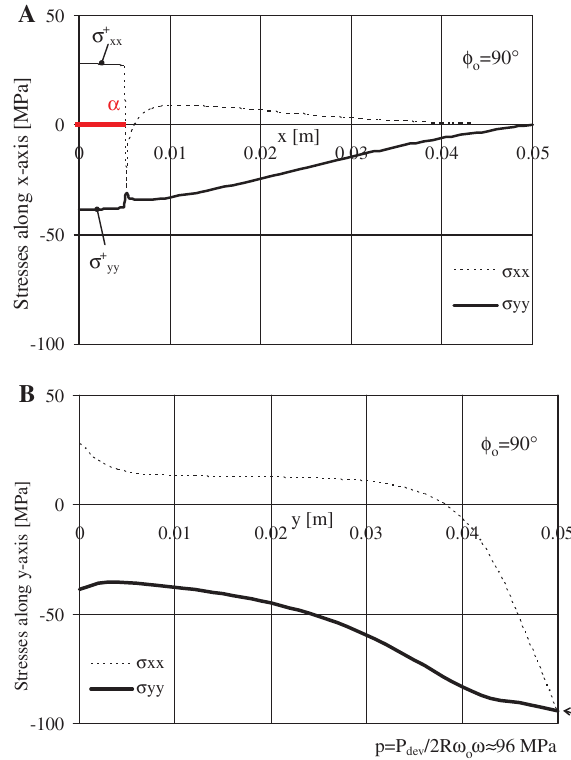
Figure 9 The variation of the stress components along the (A) x - and (B) y -axis for the case with f